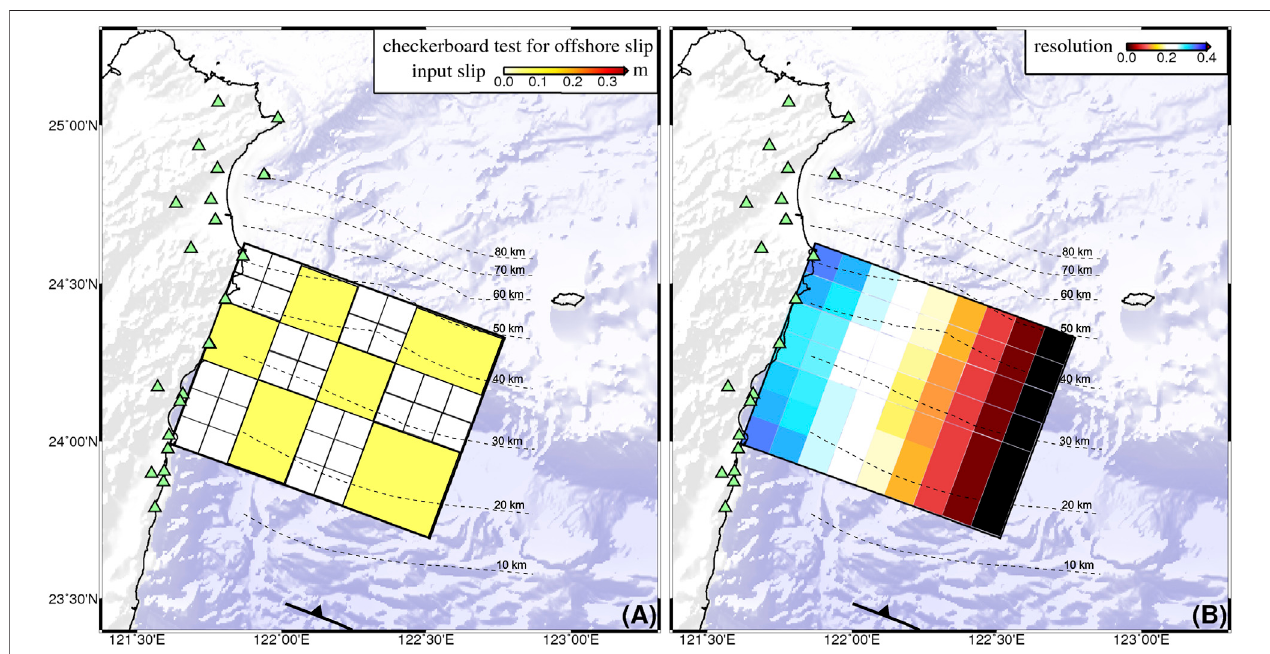
FIGURE 3 | Checkerboard test for the offshore cumulative slip distribution of SSEs on the subducting plate interface. The onshore GNSS stations for the checkerboardtestin (A) arethesameas Figure1 andareusedfortheresolutionvalueestimationin (B) .Theresolutionvalueoflessthan0.15indicatesapoorresolution of the offshore